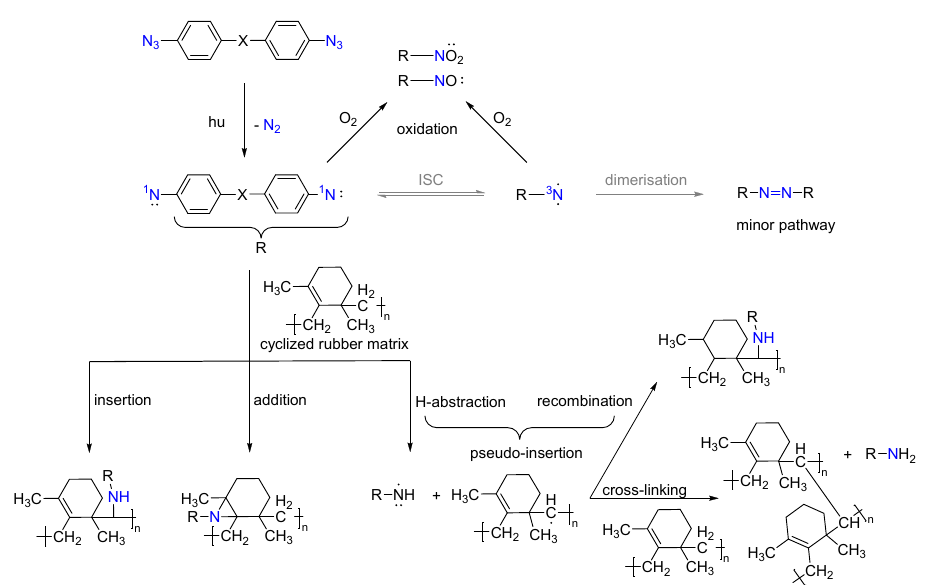
Scheme 3. Crosslinking mechanism of bisazide photoresist systems. Reactions with triplet nitrene are depicted in grey.